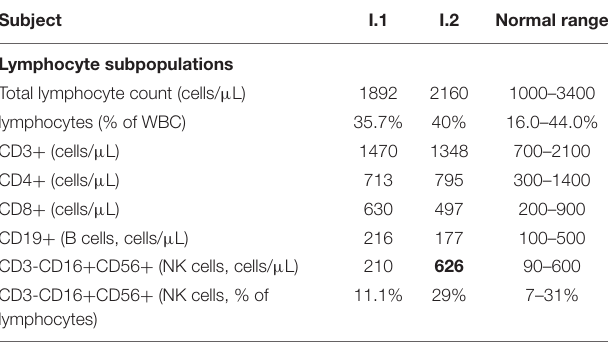
TABLE 1 | Leukocyte classes in subjects with mutation in NFKB2 gene.